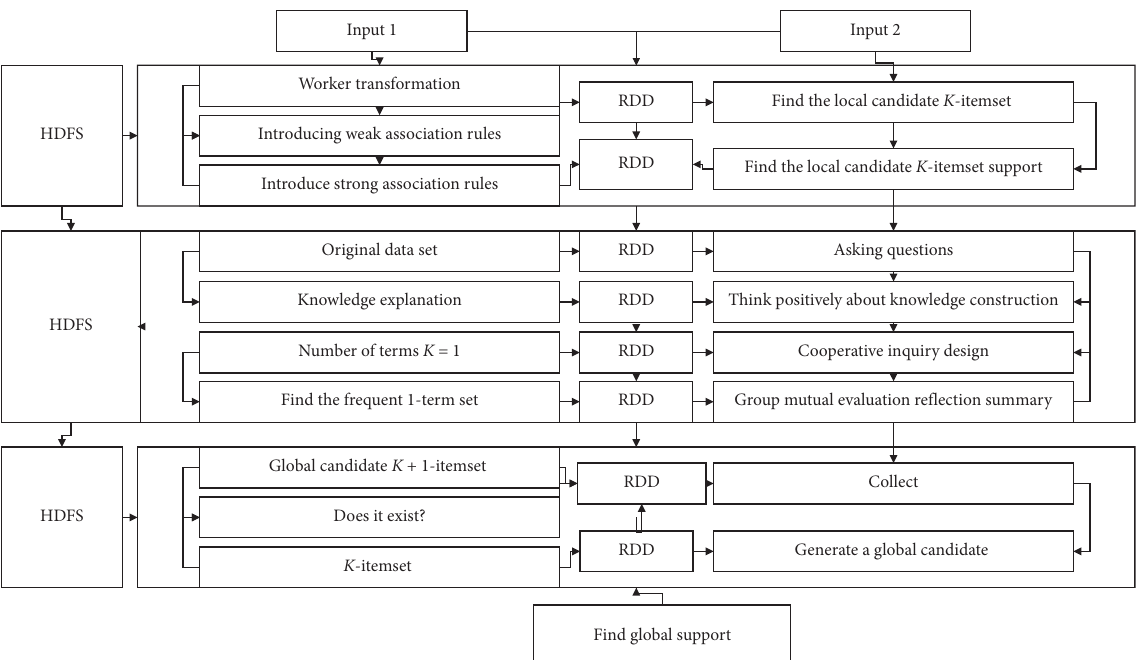
Figure 1: Algorithm parallelization framework.